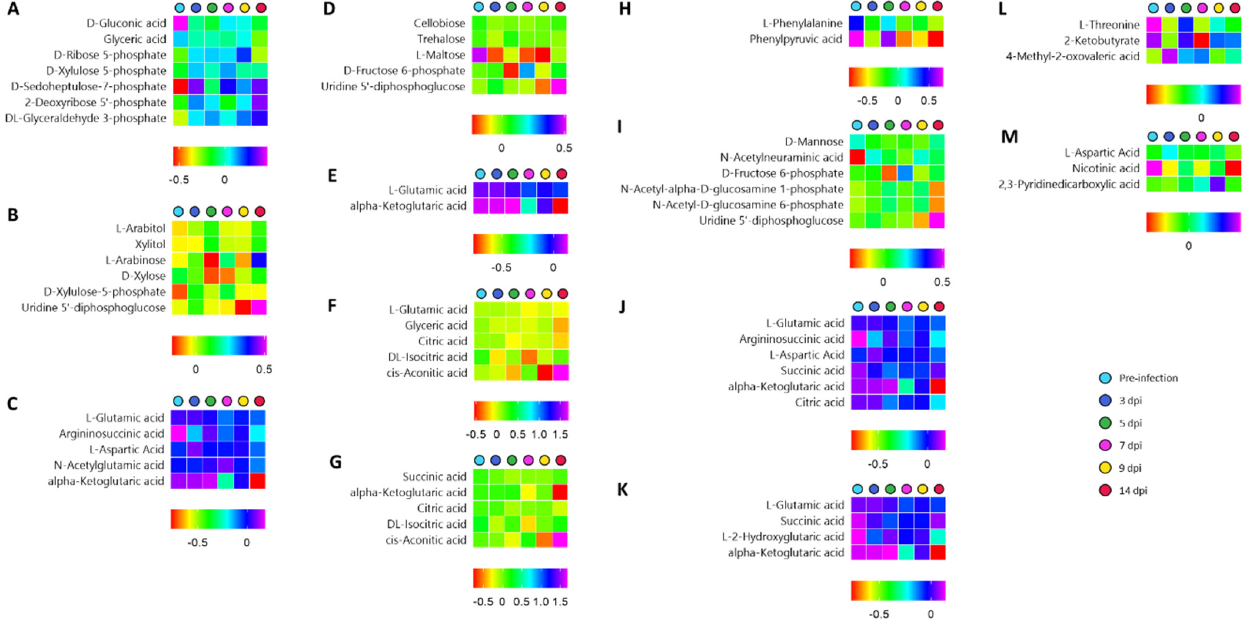
Figure 4. Time-series observed for metabolites related to the 13 significantly relevant central carbon metabolic pathways. ( A ) Pentose phosphate pathway, ( B ) Pentose and glucuronate interconversions, ( C ) arginine biosynthesis, ( D ) starch and sucrose metabolism, ( E ) D-glutamine and D-glutamate metabolism, ( F ) glyoxylate and dicarboxylate metabolism, ( G ) citrate cycle, ( H ) phenylalanine, tyrosine and tryptophan biosynthesis, ( I ) amino sugar and nucleotide sugar metabolism, ( J ) alanine, aspartate and glutamate metabolism, ( K ) butanoate metabolism, ( L ) valine, leucine and isoleucine biosynthesis, and ( M ) nicotinate and nicotinamide metabolism.